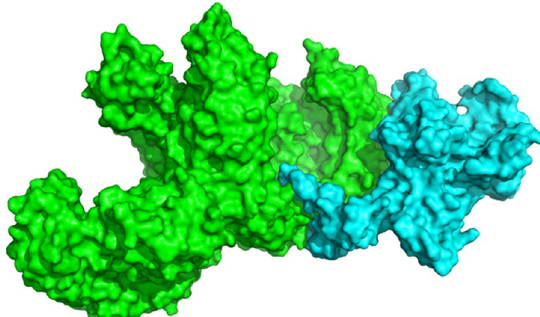
Fig. 8 A docked cluster of our vaccine with TLR4 receptor (vaccine model in cyans and TLR4 receptor in